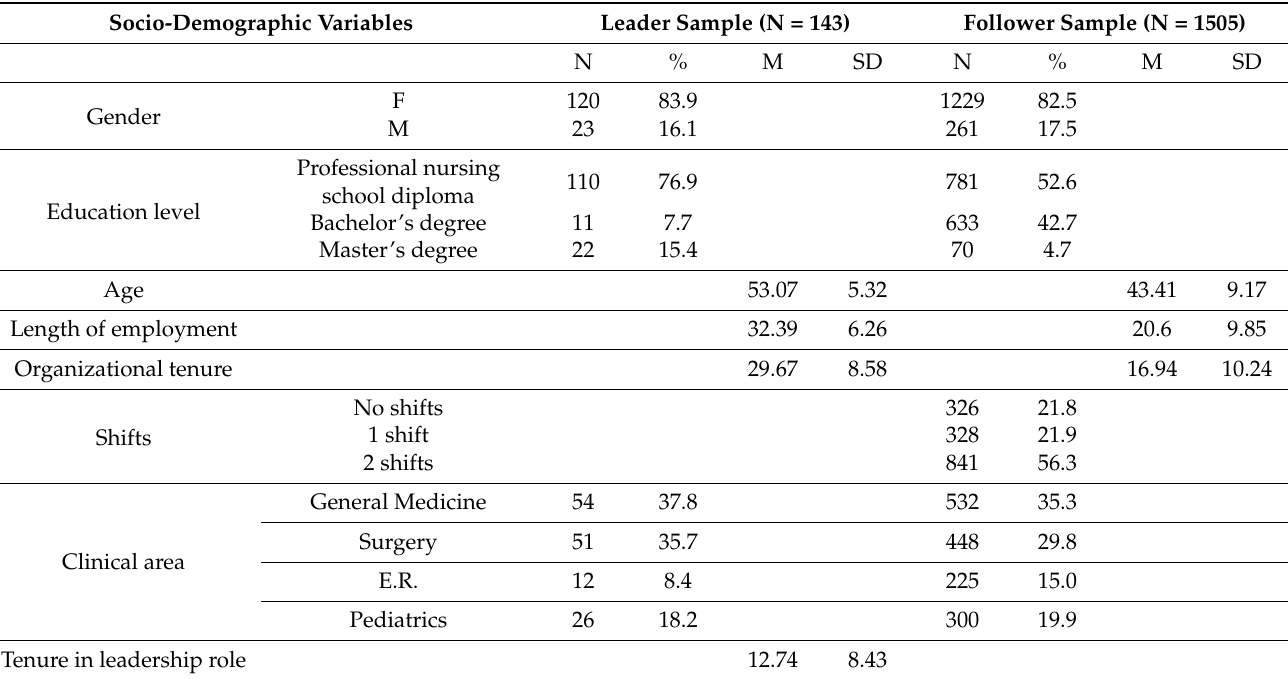
Table 1. Descriptive results of the